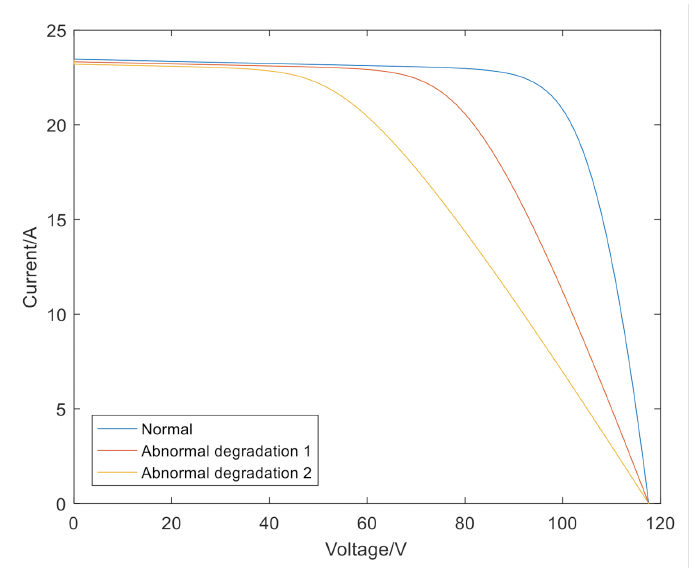
Figure 6. I-V curves of the PV array in case of the abnormal degradation faults.